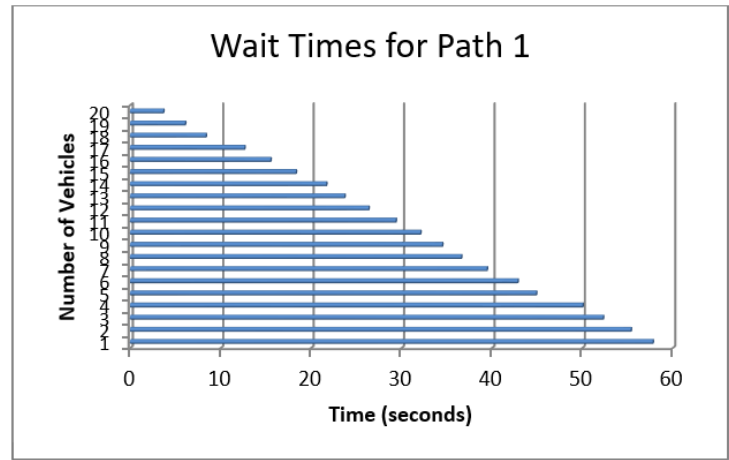
Figure 5. Wait Times for each vehicle for t2=60